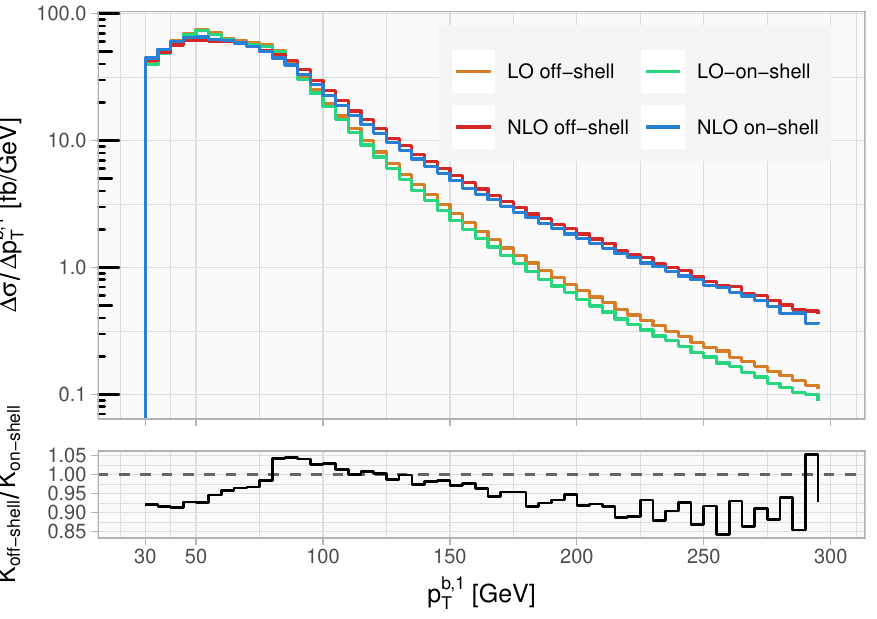
Figure 6. Leading b -jet transverse momentum distributions for the top-quark on-shell approxi- mation and for the o(cid:11)-shell top quark at LO and NLO . The lower panel shows the ratio of the NLO / LO K -factors from the o(cid:11)-shell and on-shell results.